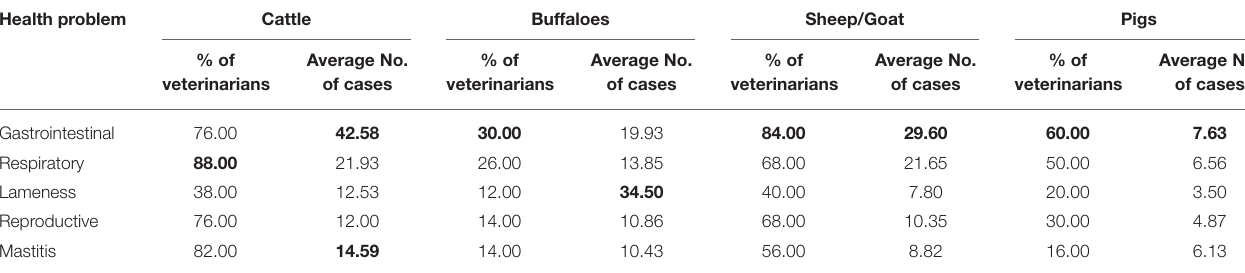
TABLE 3 | Average number of cases for different health problems given antibiotics over the last 3 months. Health